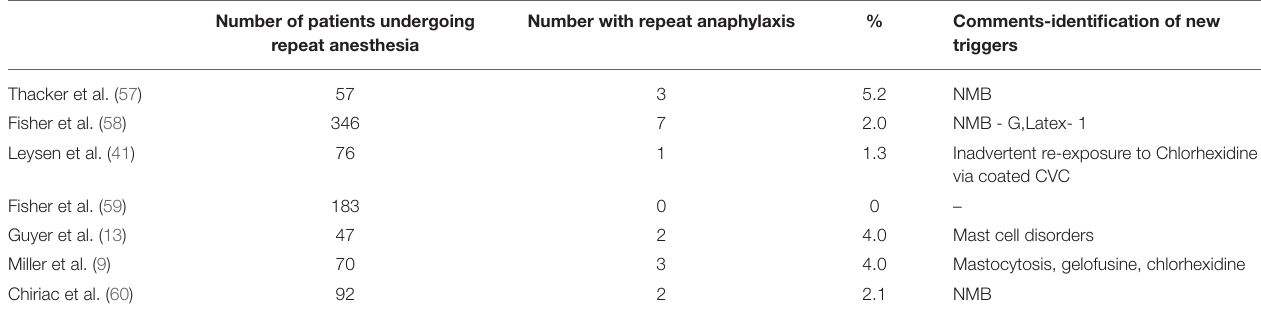
TABLE 3 | Rate of repeat anaphylaxis. Number of patients undergoing repeat